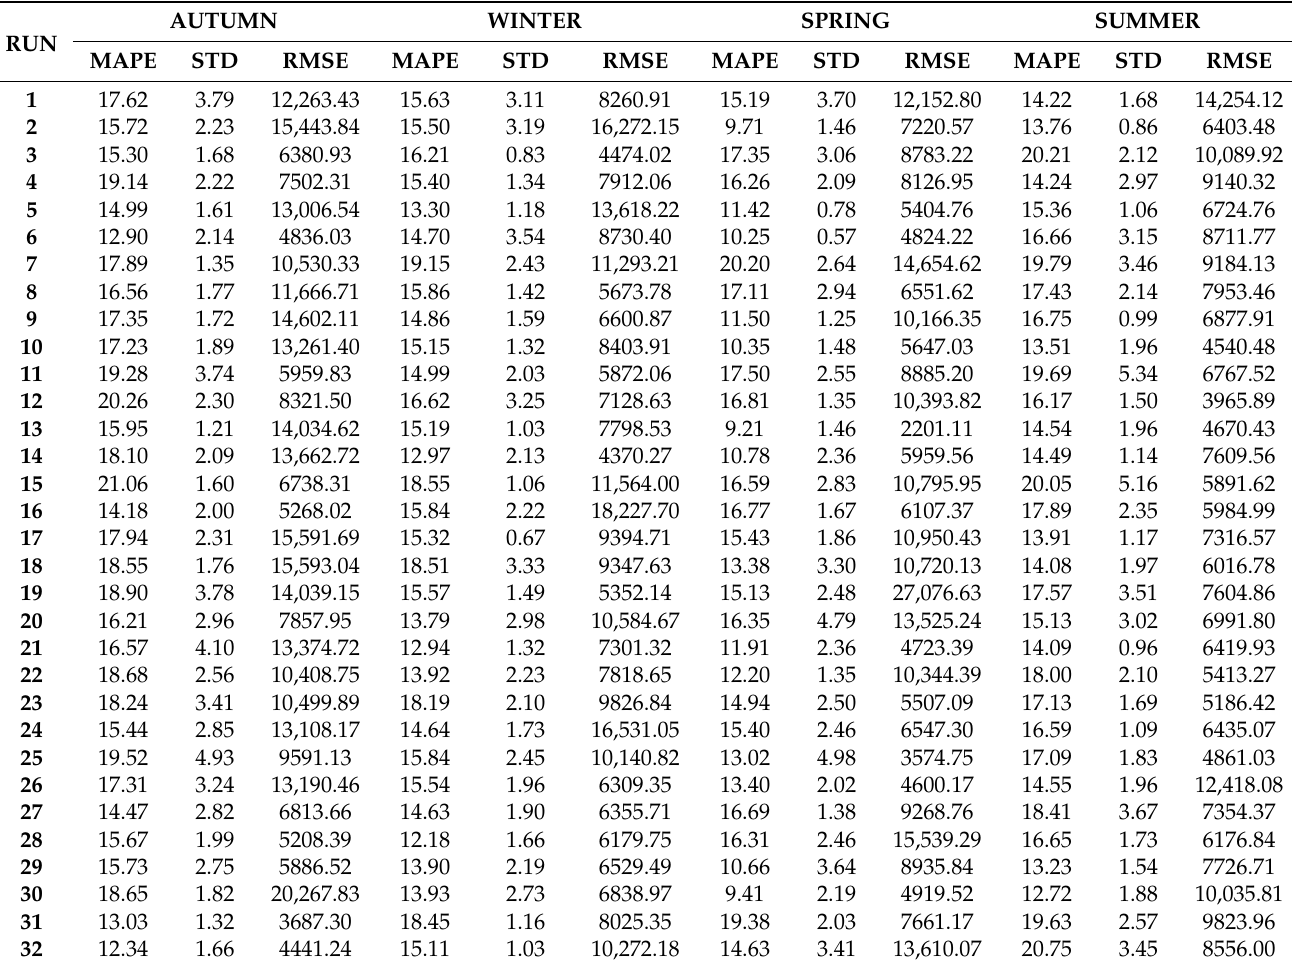
Table 5. Forecast results in terms of their mean errors (MAPEs) after each experimental run, separated by